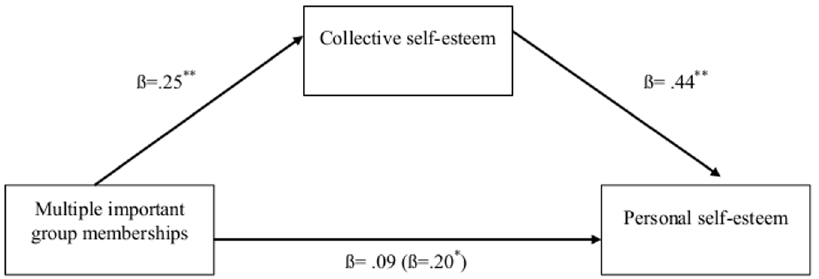
Fig 3. Study 5: the indirect effect of collective self-esteem on the relationship between multiple group memberships and personal self-esteem for University students in the US. Note . * p < .05, ** p < .01. Correlations were based on a sample of N = 148. Beta within parentheses represents the direct